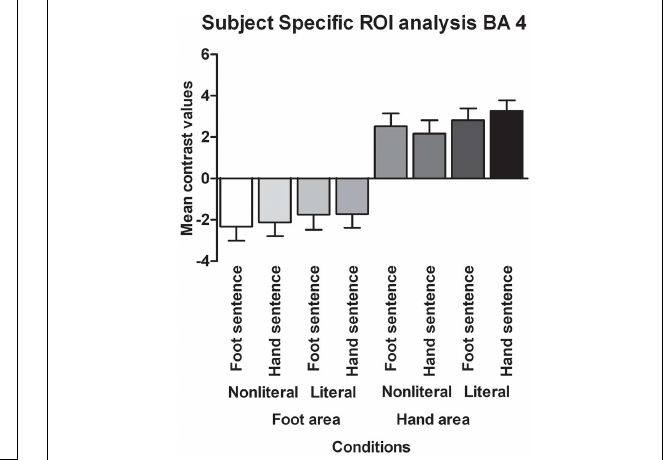
FIGUREA3 |Additional functionally defined, subject-specific ROI analysis for the foot area and hand area in BA 4. The mean contrast values compared to an implicit baseline are shown for each sentence type and extremity.